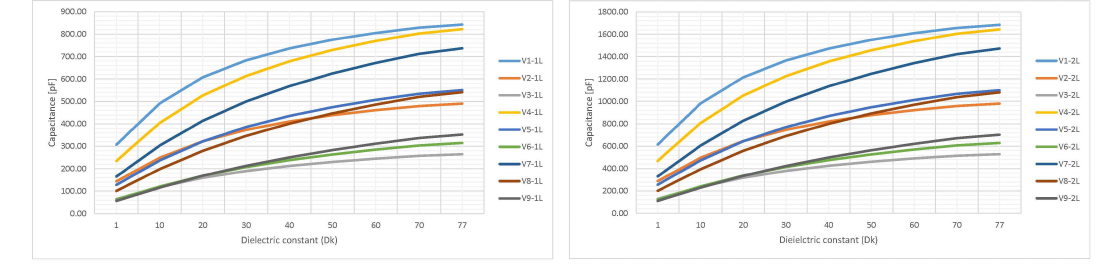
Figure 12. Simulation results of capacitance variation for the 18 structures when the (cid:101) r of the environment is swept from 1 to 77. Graphs display the absolute value in pF of the capacitance obtained by multiplying the increase factor with the initial capacitance from Table 1.